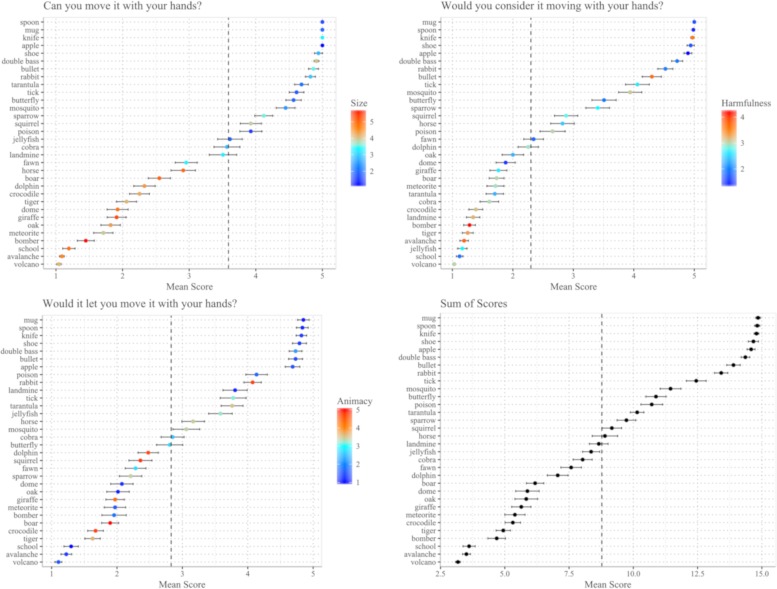
Overview of manipulability scores per word.The figures display mean scores for each word on each of the three questions. Error bars reflect the standard error of the mean. Values in the bottom right panel correspond to the mean (across participants) of the sum of the three scores. Colors indicate the SVR-derived scores along the animacy, size, and harmfulness dimensions used in the parametric analysis.